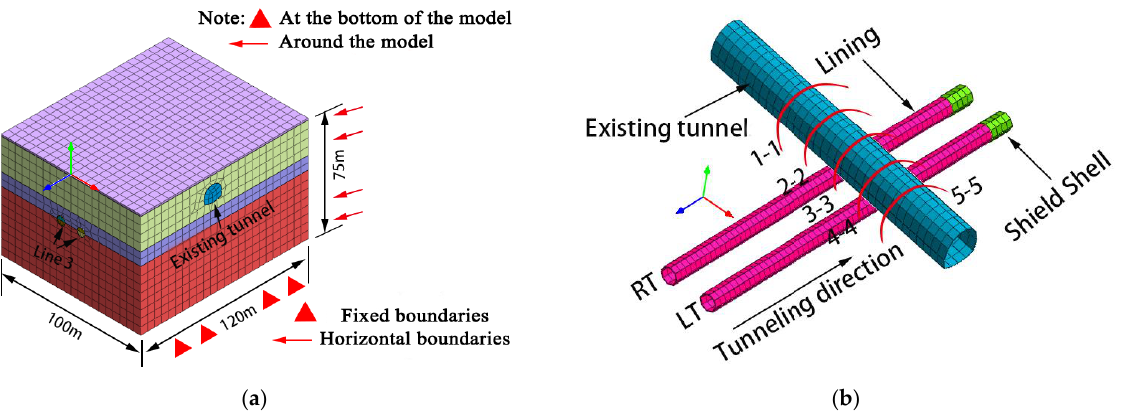
Figure 3. Schematic diagram of finite element model: ( a ) three-dimensional numerical model; ( b ) spatial location model of old and new tunnels.